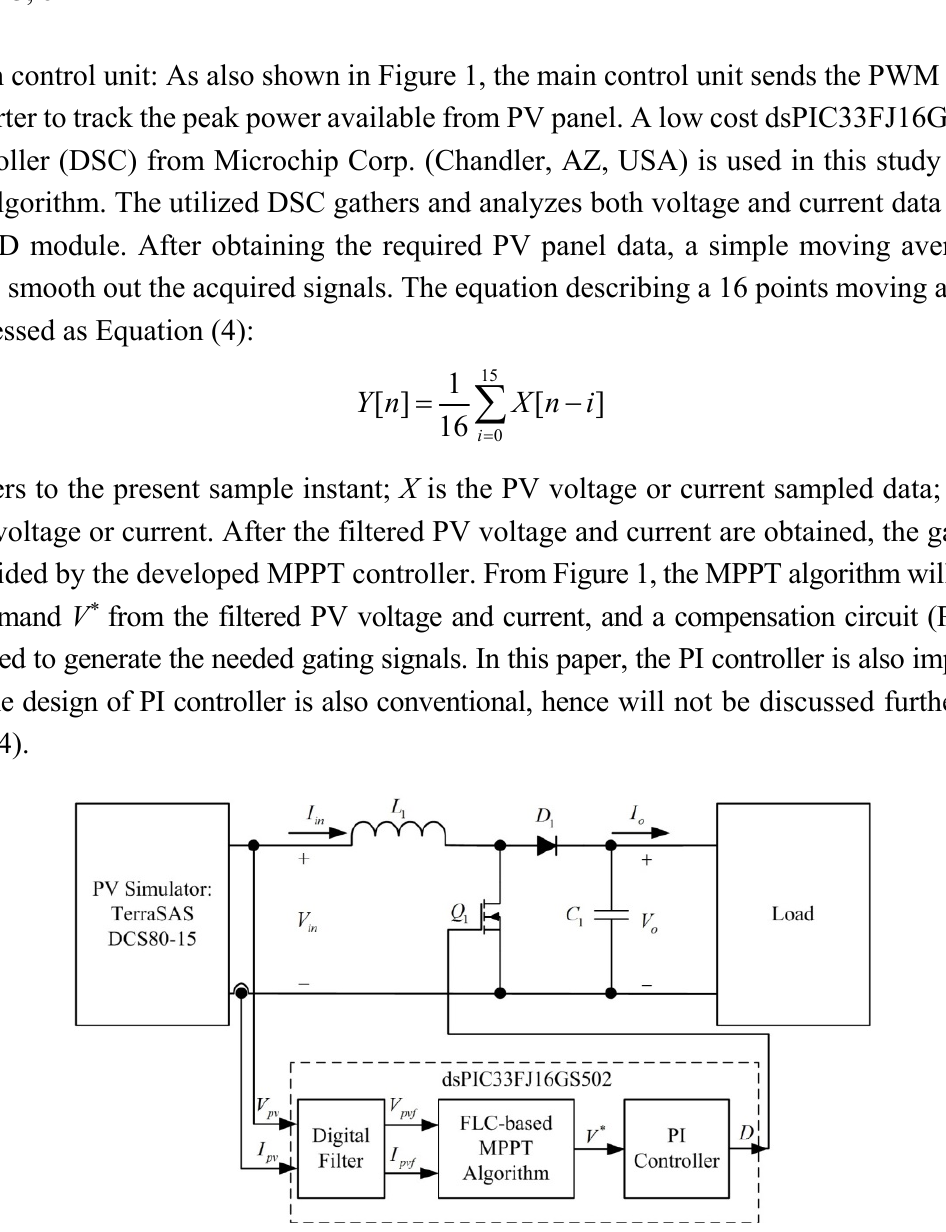
Figure 1. The block diagram of the proposed